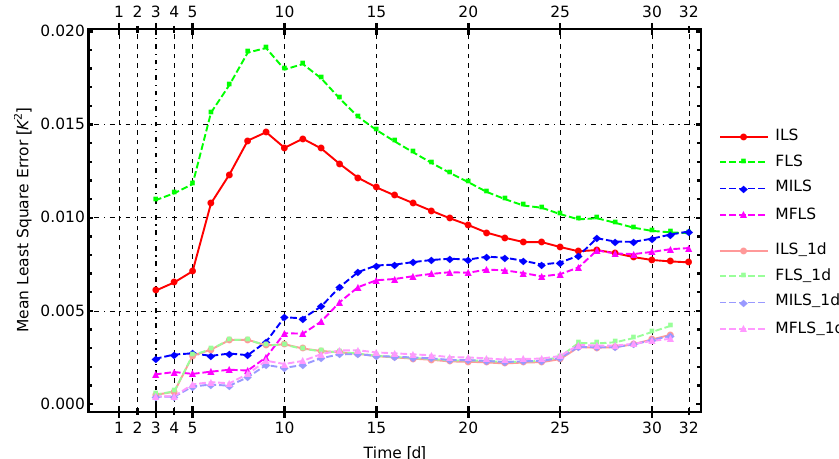
Figure 7. Mean least square error between theoretical models and measured data for the four different models as a function of the data time window used, but considering only data gathered after day 1 for the analysis (light colors). To compare, the previous least square error (LSQ) data from Figure 3d are included.